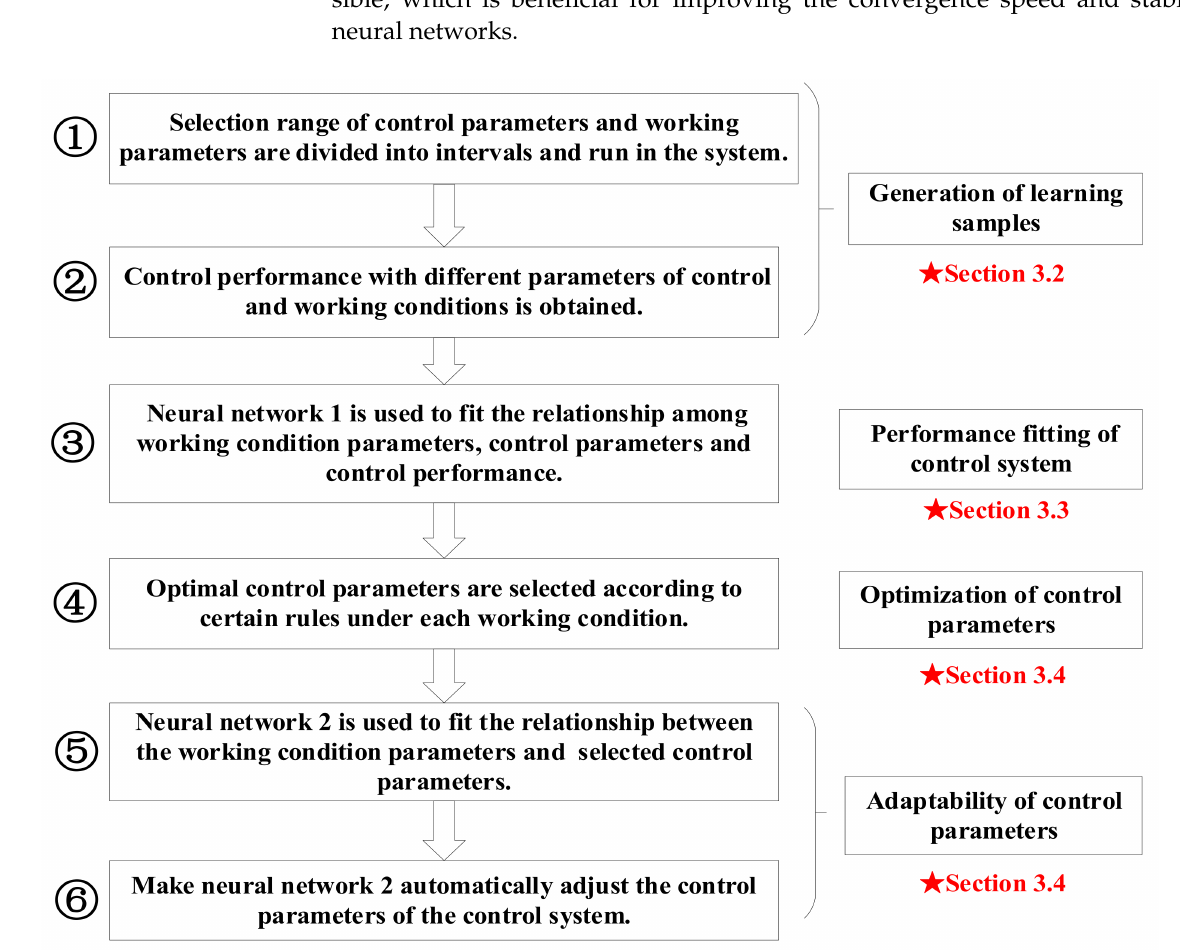
Figure 3. Learning steps of the adaptive parameters in the neural network.